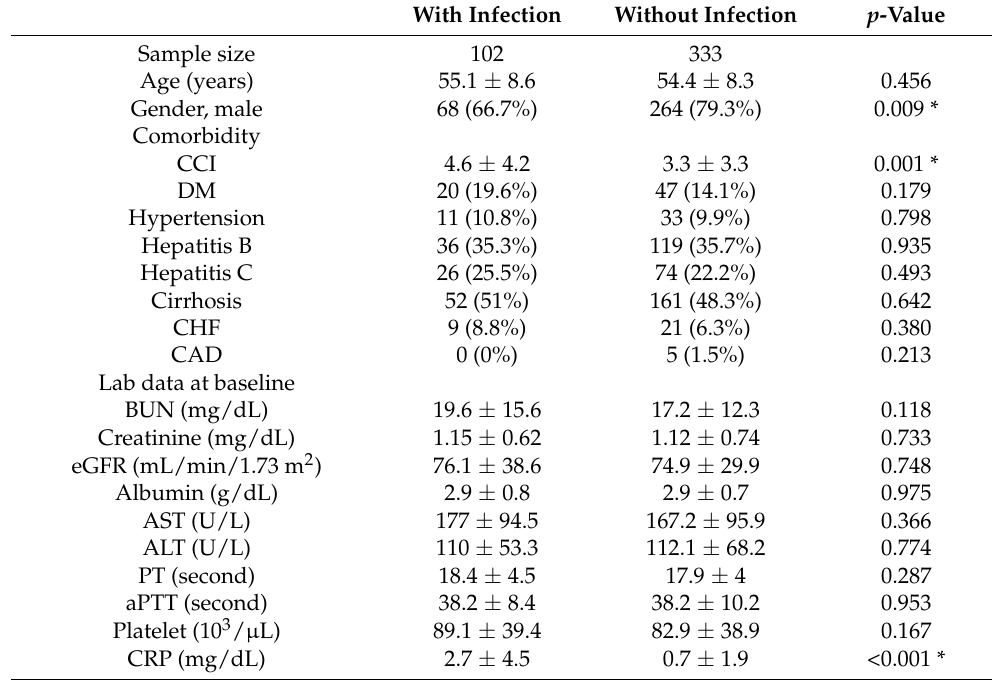
Table 1. Patient